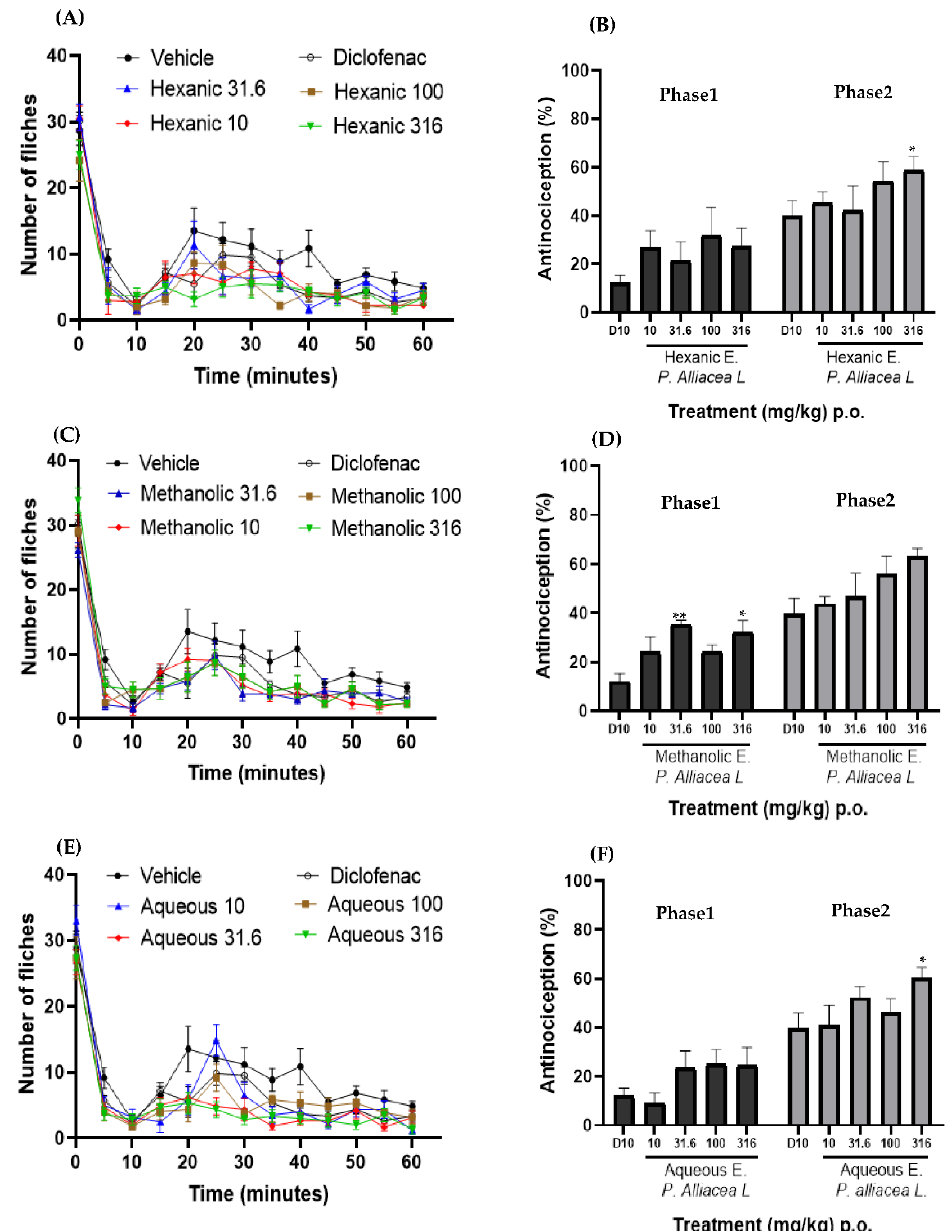
Figure 1. Subfigures show the time courses ( A ) hexanic extract, ( C ) methanolic extract and ( E ) aqueous extract, each point represents the mean ± S.E.M. n = 6/group. Subfigures represent the dose-response graphs expressed as area under the curve of the time course corresponding to ( B) hexanic extract, ( D) methanolic extract and ( F) aqueous extract of the P. alliacea L. leaves. Bars are the mean ± S.E.M., n = 6/group. * p < 0.05; ** p < 0.01 vs. D10 (diclofenac 10 mg/kg) as determined by one-way